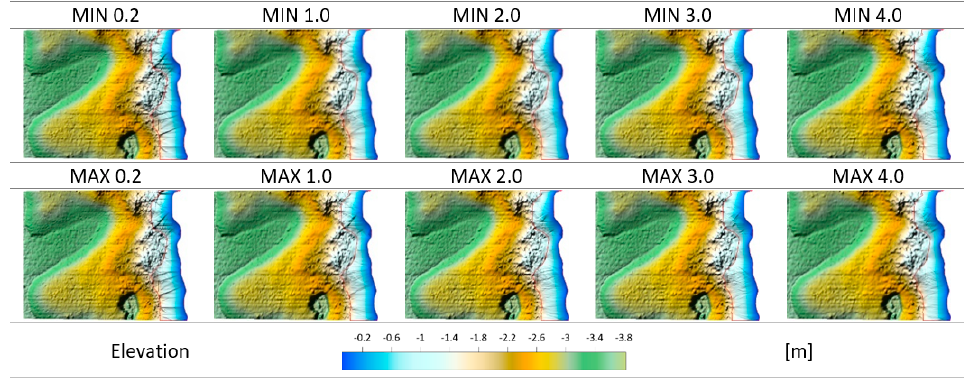
Figure 18. Comparison of DBMs under the RBF method.